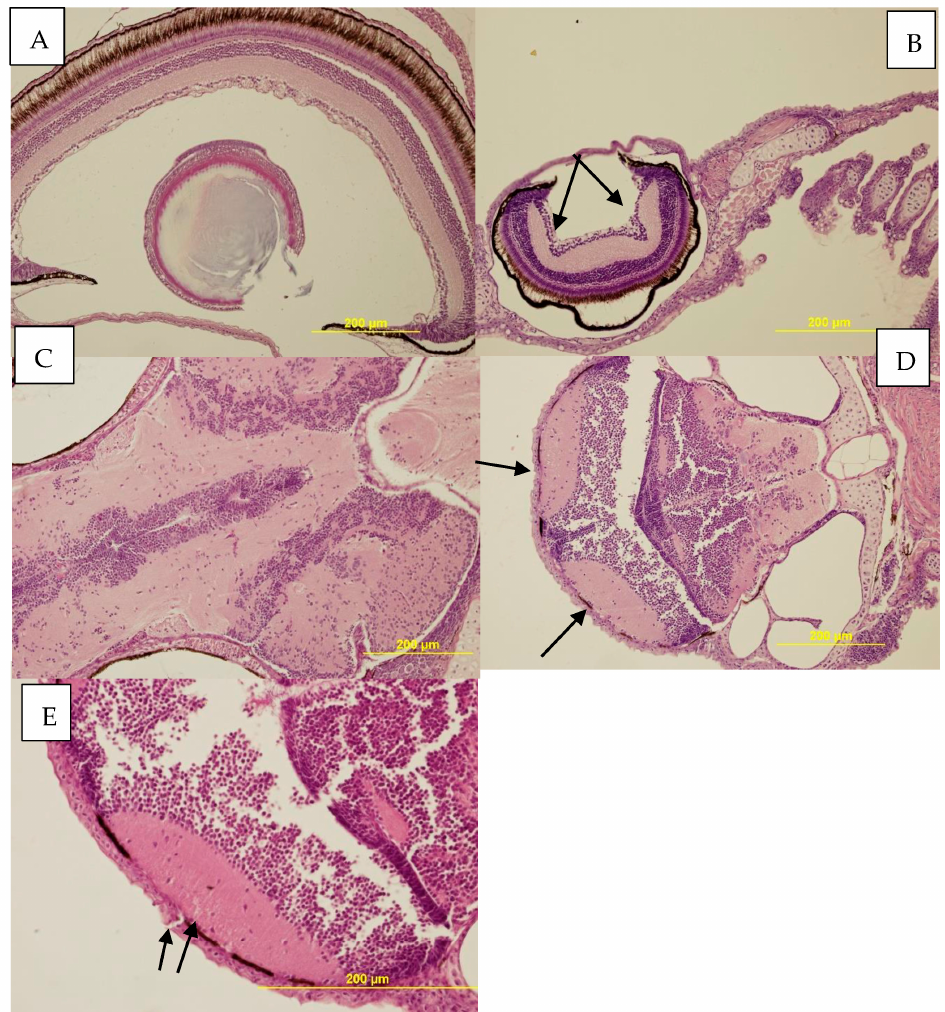
Figure 8. The eye in the control group ( A ) and deformation of an eye after exposure to 1000 µ g/L of PCZ ( B ), indicated by black arrows. The normal structure of the brain at the control group ( C ) and (submeningeal lesion with alterations in the brain) after exposure to 1000 µ g/L of PCZ; ( D ) magnification 200 × ; ( E ) magnification 400 ×